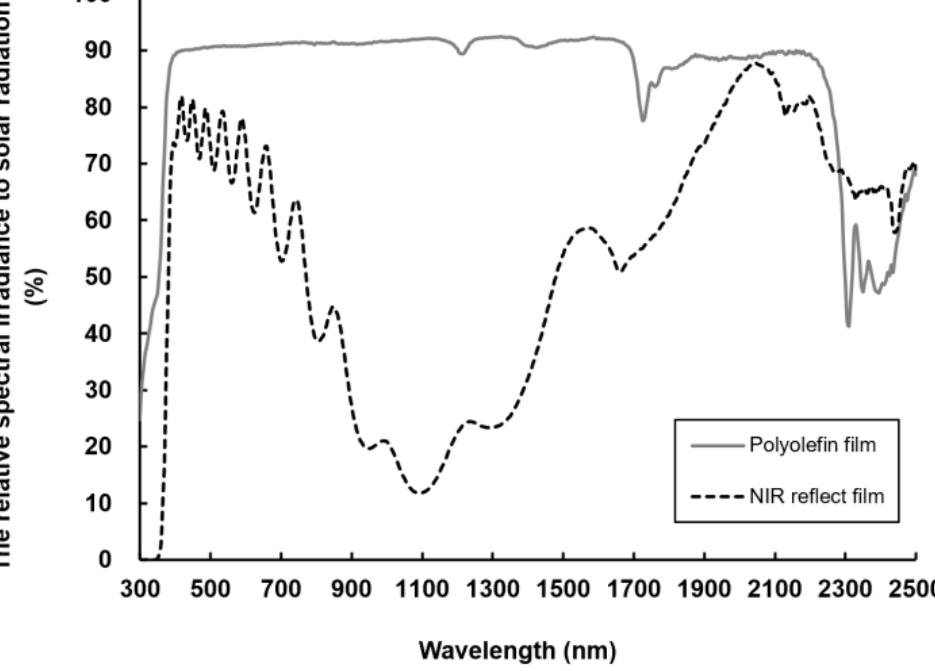
Figure 1. The relative spectral irradiance of polyolefin film (PO) and NIR reflective film (NR) to solar radiation in the present study.